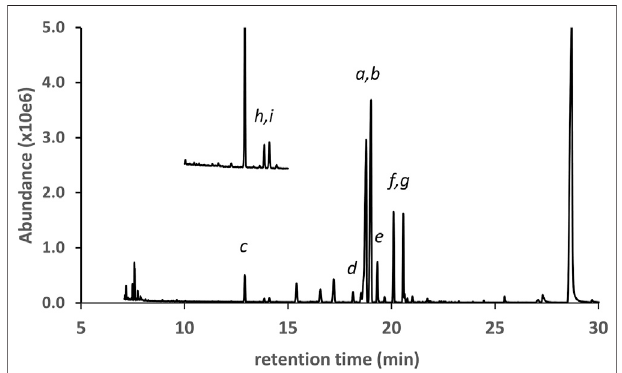
FIGURE7 | GC-MSchromatogram fora cannabis vaping liquid inwhich thepredominantTHCisomerswered9THC( a )andd6a,10aTHC( b ).Additional THC isomers were identi fi ed as follows: d8THC( d ), 6aR,9S-d10THC( e ), and 6aR,9R-d10THC( f ). Other cannabinoids include CBD( c ), CBN( g ), and the varinols (expanded scale, offset): d9THCV( h ) and d6a,10aTHCV( i